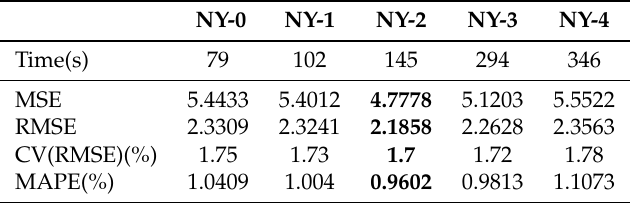
Table 4. Summary of accuracy metrics for RNN LSTM model forecasting: New